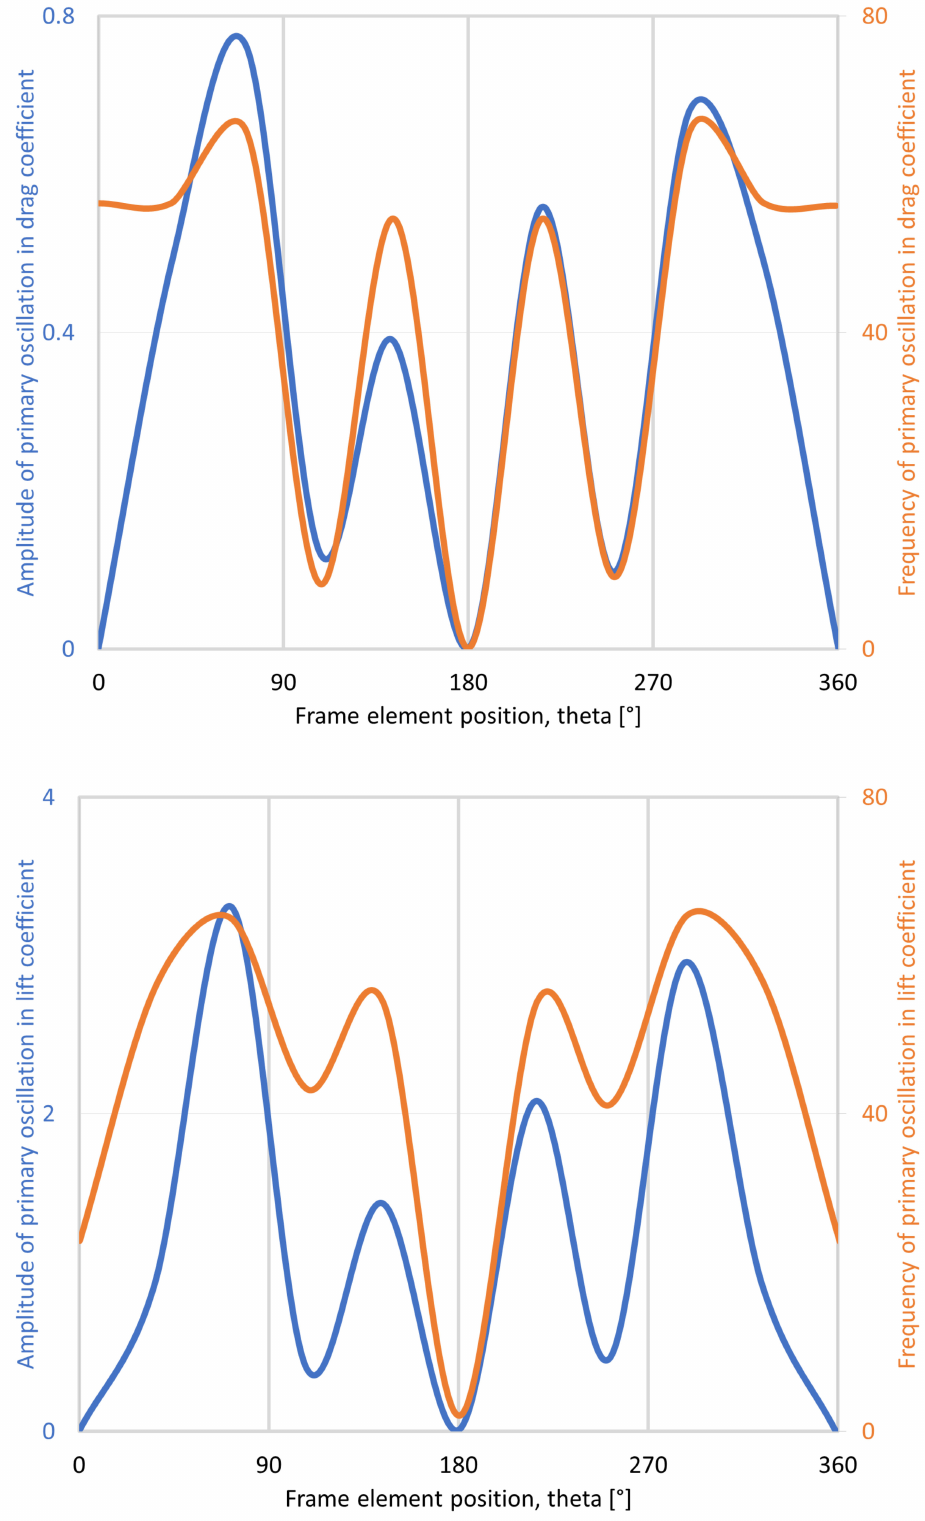
Figure 17. Amplitude and frequency of primary oscillation in drag ( top ) lift ( bottom ) coefficient for the helideck frame elements as a function of angular position for an incident wind speed of 27.1